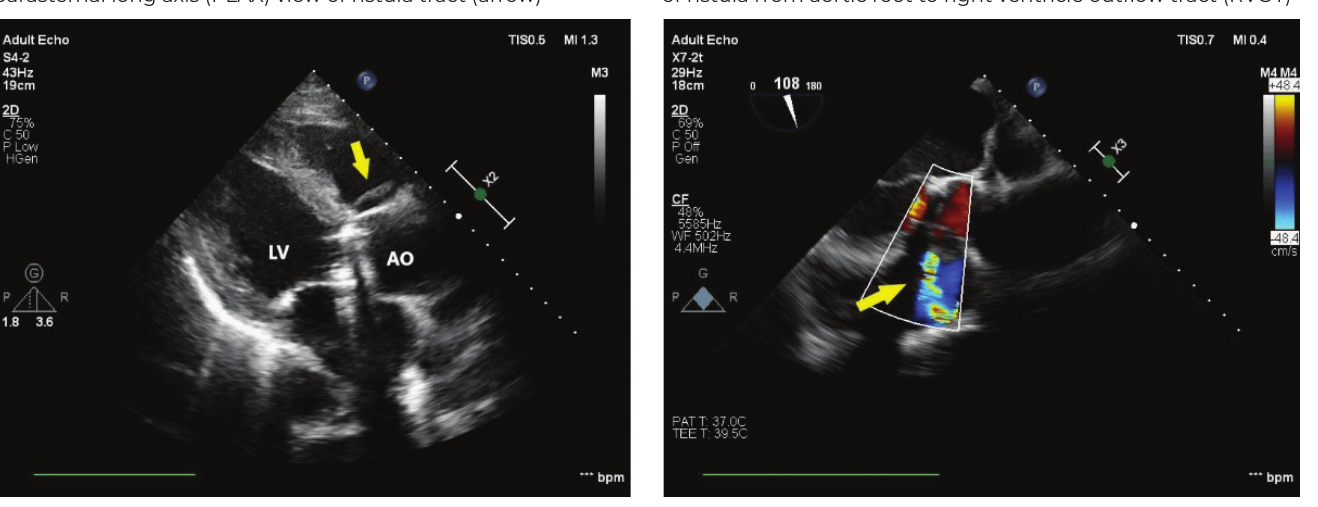
Figure 1 - Two-dimensional transthoracic echocardiogram parasternal long axis (PLAX) view of fistula tract (arrow)